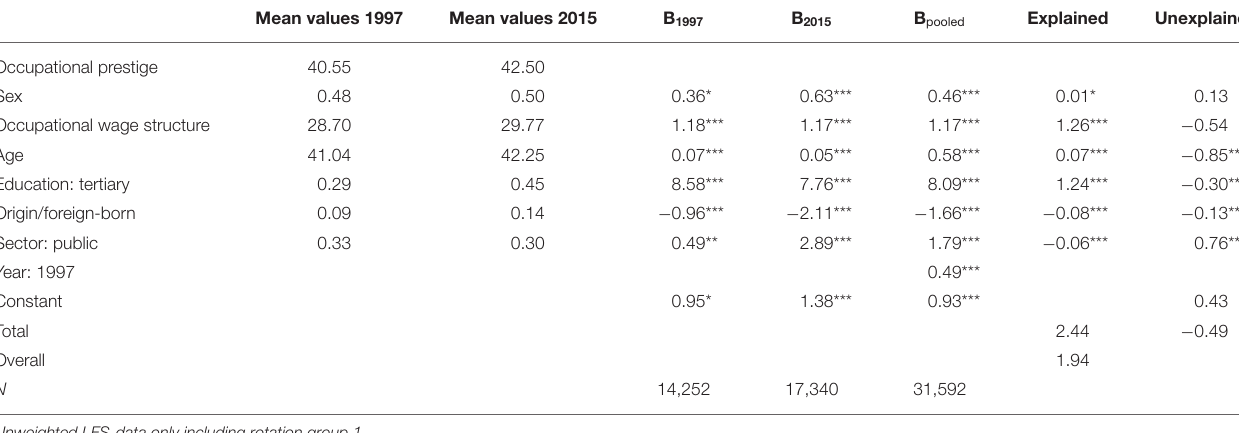
TABLE 2 | Blinder-Oaxaca decomposition of the change in occupational prestige between 1997 and 2015.